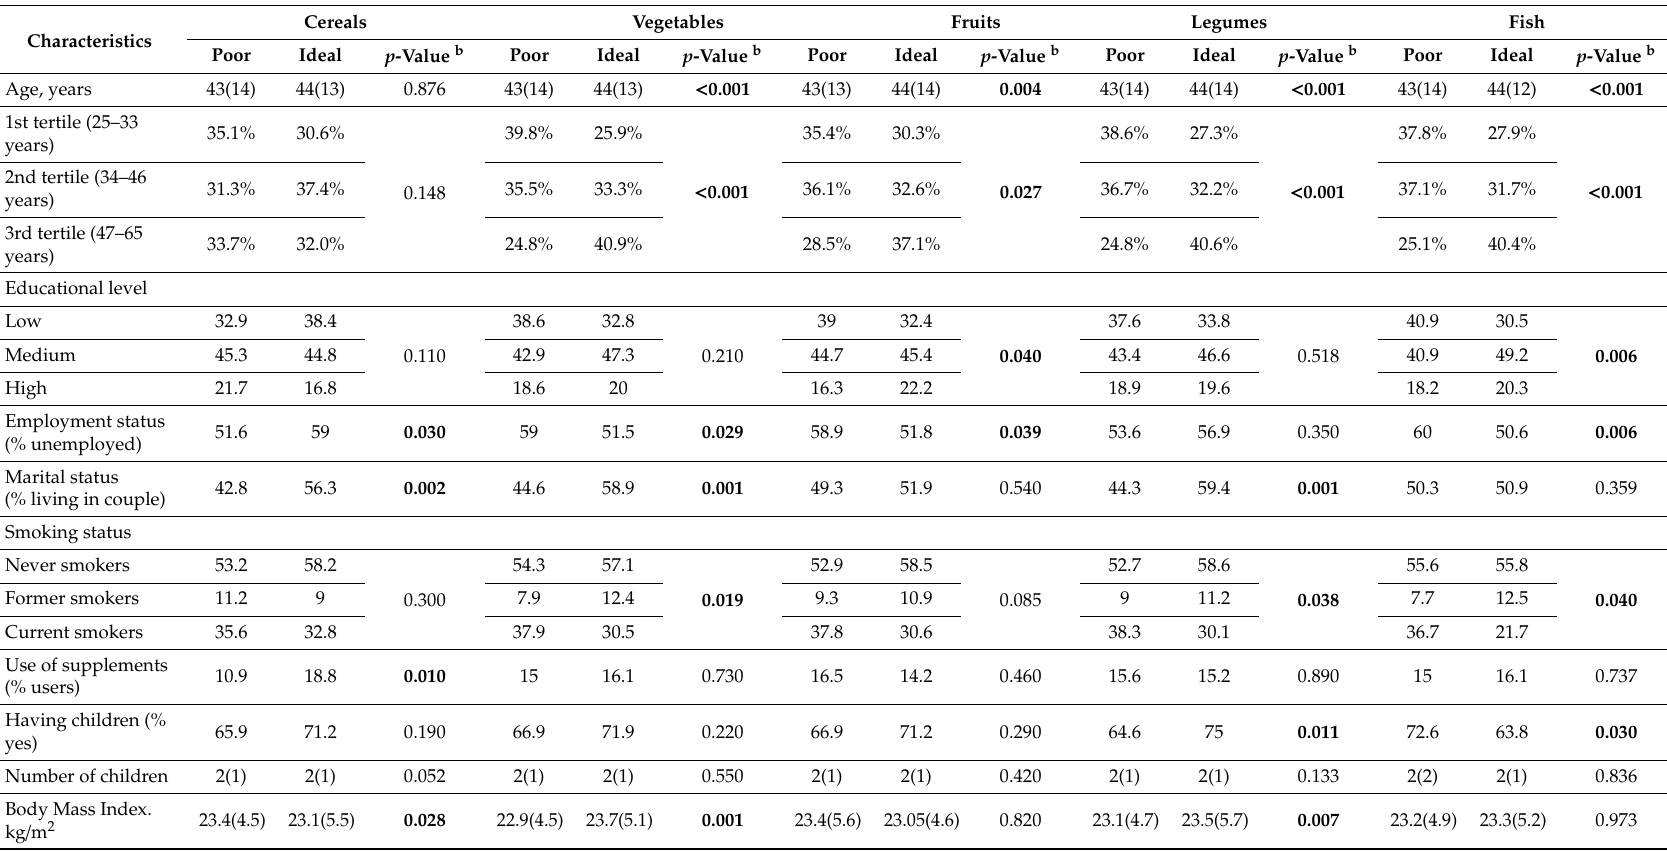
Table 1. Characteristics of women according to consumption of cereals, fruits, vegetables, legumes, and fish a